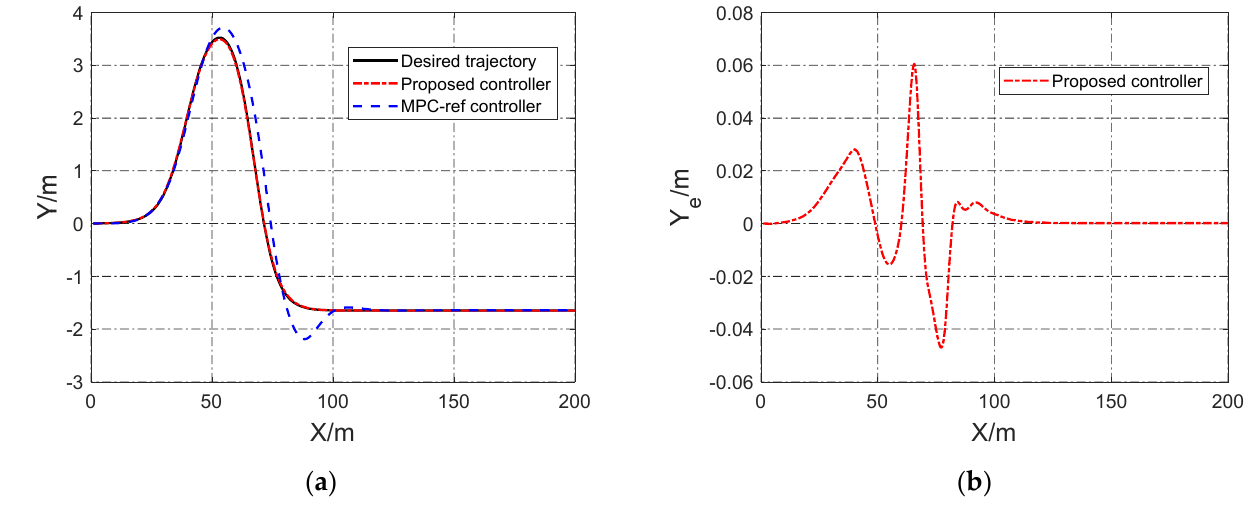
Figure 14. Trajectory tracking results compared to the algorithm proposed at 45 km ∙ h (cid:2879)(cid:2869) ; (a) Comparison of driving paths; (b) Comparison of lateral errors.